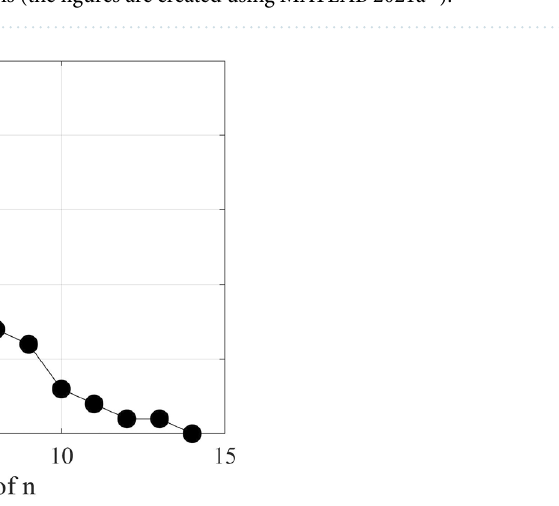
Figure 8. Change in the number of existing petroleum deposits covered by n-vote instances with an increasing value of